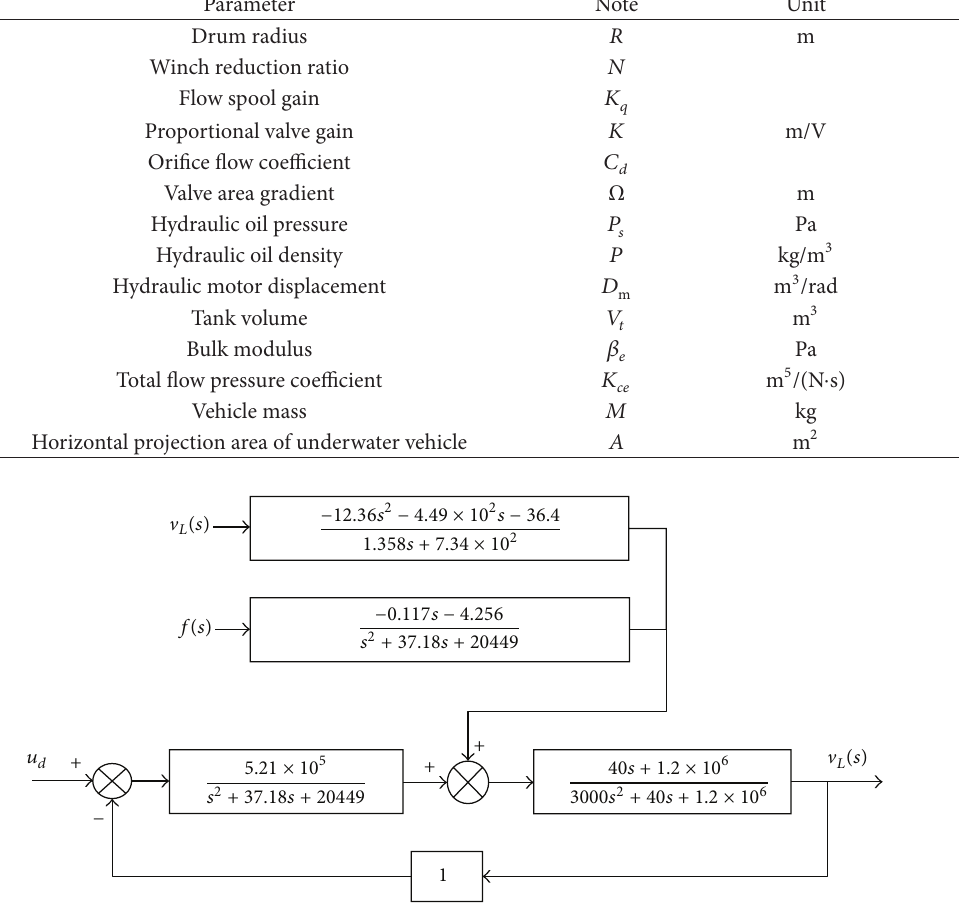
Figure 9: The transfer function diagram of the underwater vehicle speed control